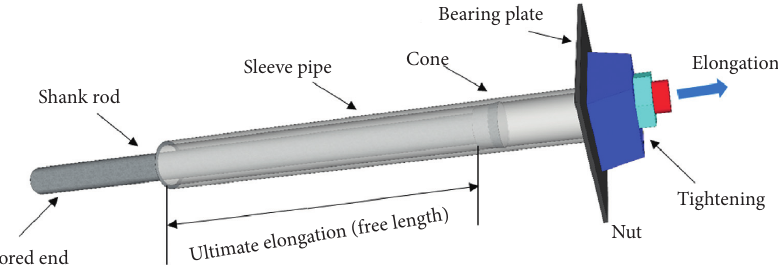
Figure 7: Schematic of three-dimensional view of NPR